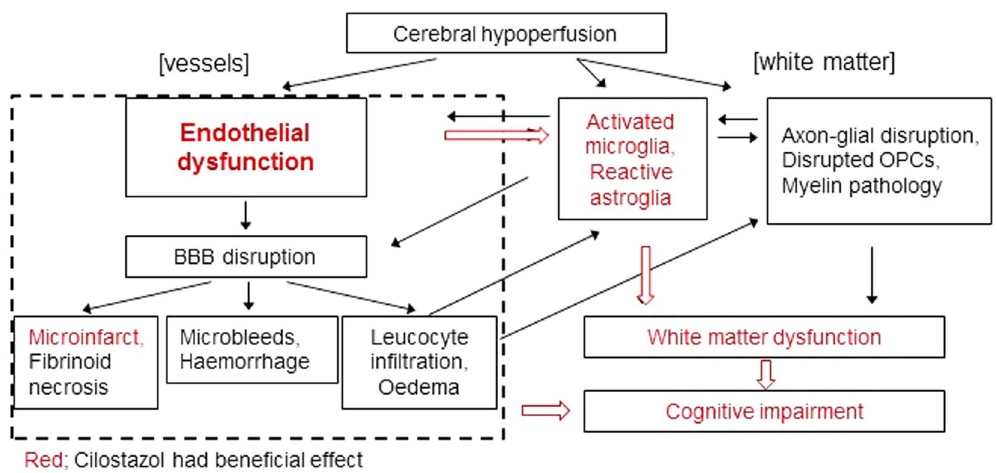
Figure 7. A proposed mechanism by which cilostazol may improve cognitive impairment induced by chronic cerebral hypoperfusion. Cilostazol reduced the number of stroke lesions and significantly ameliorated the spatial working memory impairment and white matter dysfunction induced by chronic cerebral hypoperfusion. Remarkably, cognitive deficits seem to be closely associated with the hypoperfusion-induced neuroinflammatory processes which are significantly decreased with cilostazol treatment. Cilostazol might restore endothelial dysfunction without apparent BBB disruption leading to recovery of neuroinflammation and white matter dysfunction (large